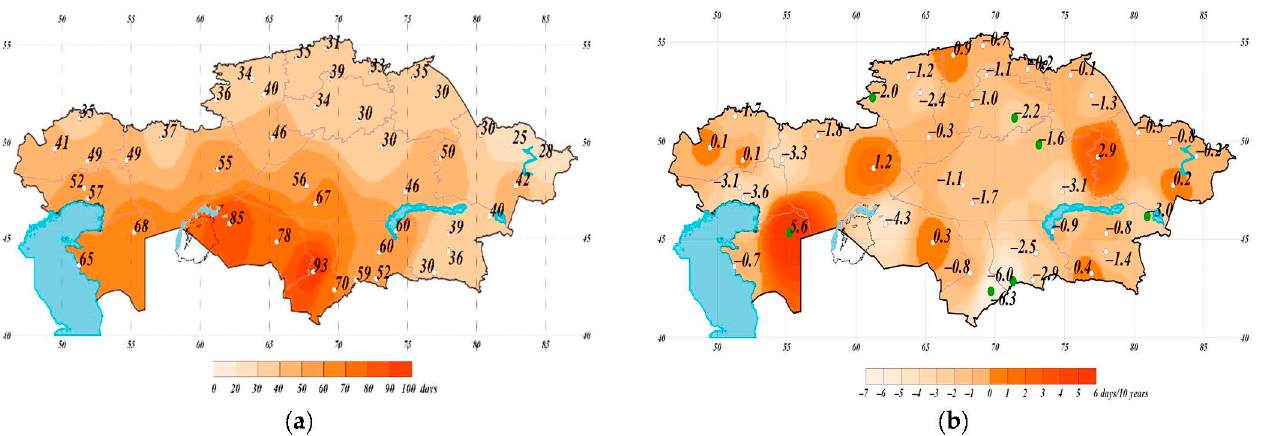
Figure 13. Spatial distribution of indices characterizing the distribution of precipitation amounts more than 10 and 20 mm per day R10mm ( a ), R20mm ( c ), and the heir trends ( b , d ) of these param- eters for the period 1971–2020.